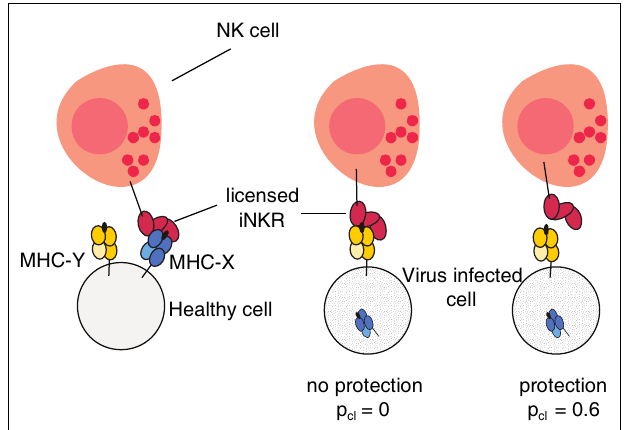
FIGURE 1 | Model cartoon of the protection after infection with an MHC-downregulating virus . An iNKR becomes licensed if it binds at least one MHC molecule in the host. In this example, the iNKR is licensed by binding the MHC-X molecule in that host. The virus downregulates the expression of all MHC-X molecules. The infection can be cleared with a probability p cl = 0.6 if and only if the licensed iNKR fails to bind all MHC-Y molecules in that host (see Materials and